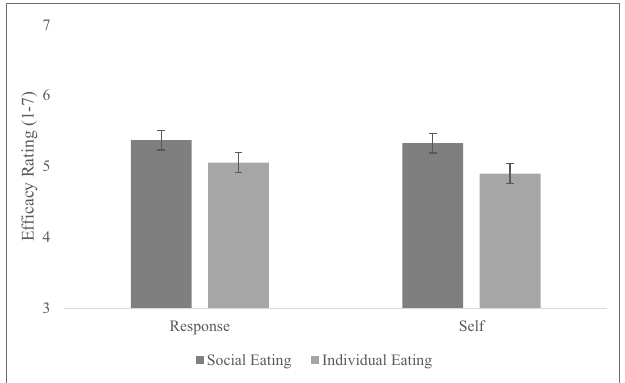
FIGURE 3 | Efficacy ratings as a function of type of social eating cues present in the obesity PSA messages.